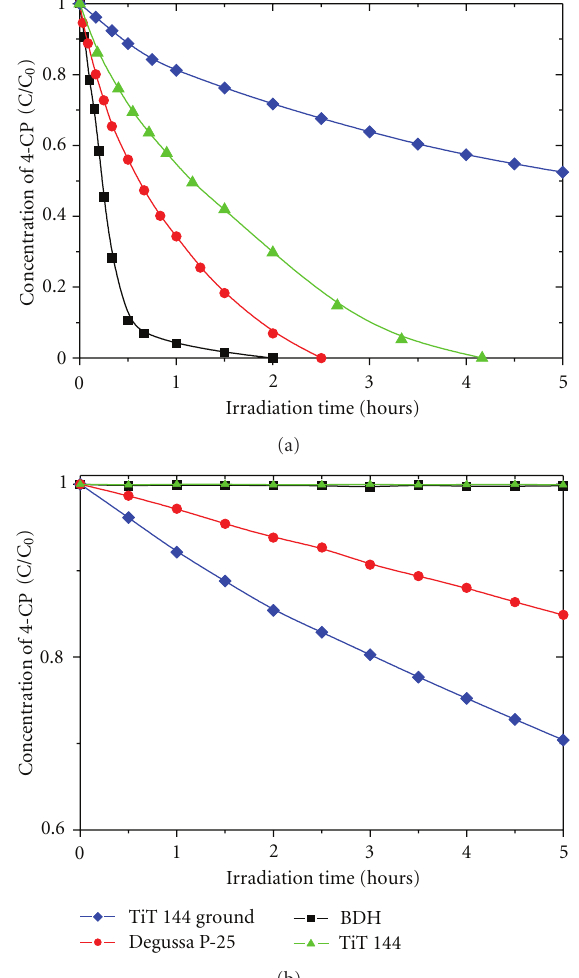
Figure 9: Photocatalyzed decomposition of 4-CP under UV (a) and vis (b)